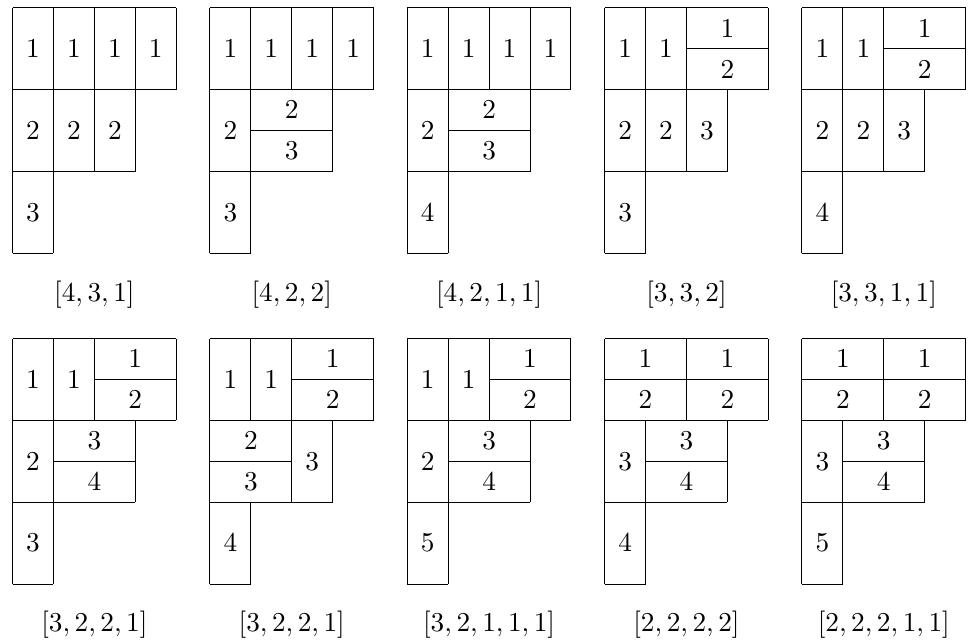
Figure 6 . The possible Yamanouchi domino tableaux of shape [4,4,3,3,1,1]. The evaluation of each tableau is given